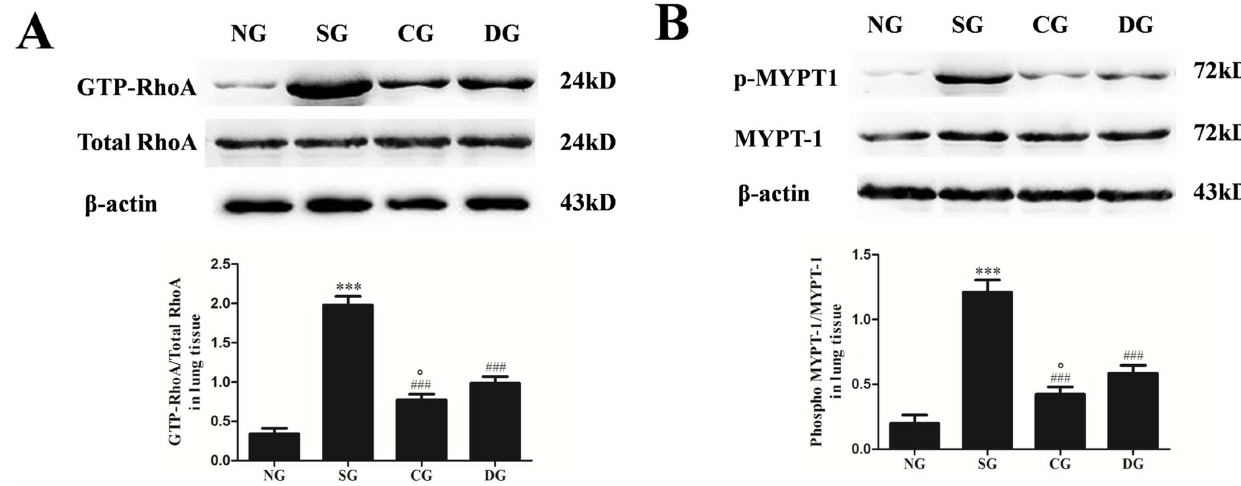
Figure 3. Effects of calcitriol on the GTP-RhoA and p-MYPT1 in lung tissues. Proteins were obtained at 4 h after seawater aspiration. The ratios of GTP-RhoA versus total-RhoA and p-MYPT1 versus MYPT1 were obtained for each group to examine the GTP-RhoA (A) and p-MYPT1 (B) contents. NG: normal group; SG: seawater group; CG: 25 m g/kg calcitriol group; DG: dexamethasone group. n=6, ***P , 0.001 versus group NG, ### P , 0.001 versus group SG, u P , 0.05 versus group DG.